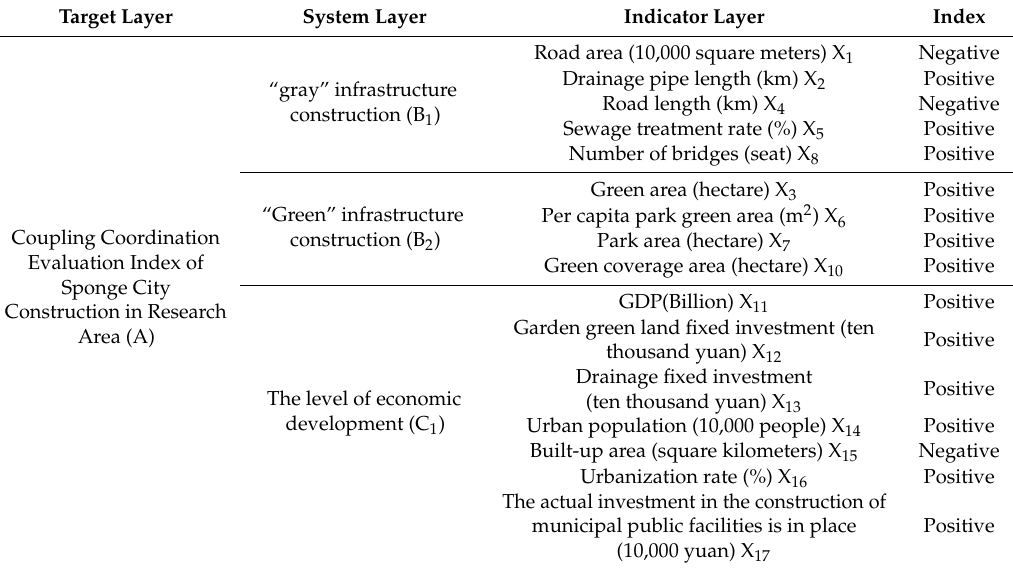
Figure 2. Annual average temperature and annual precipitation in the study area. Table 1. Coupling coordination evaluation index system for sponge city